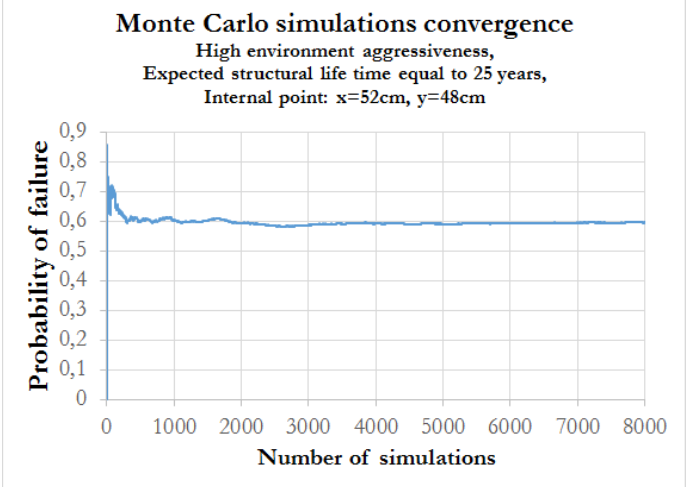
Figure 19 – Convergence analysis for x = 52 cm, y = 48 cm and t = 25